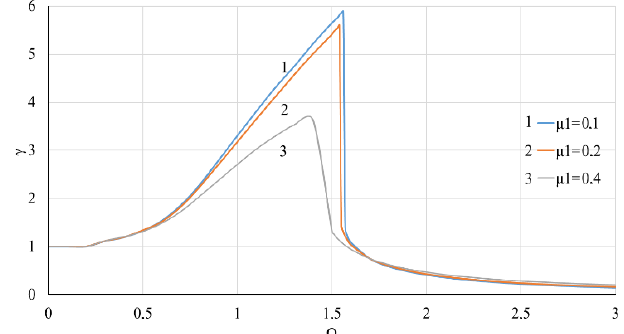
Figure 7. Dependence of the moment of force transmissibility of the system γ on the rotor velocity (cid:127) with linear stiffness of the support and at value of the coefficient of linear viscous damping µ 1 = 0 . 1 and various values of nonlinear viscous damping coeffi- cient µ 3 .